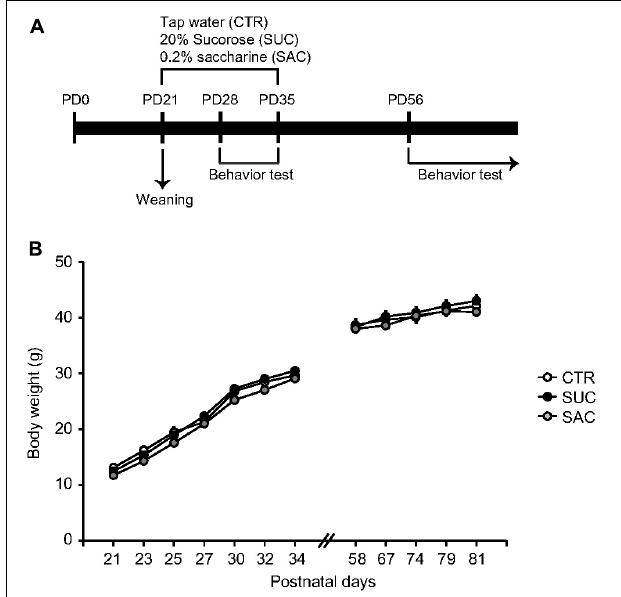
FIGURE 1 | Experimental schedule and body weight gain. (A) Schematic diagram illustrating the timeframe of experiments. (B) Graph showing body weight gain of animals with vehicle (CTR), 20% sucrose (SUC), and 0.2% saccharine (SAC) treatments. Error bars indicate